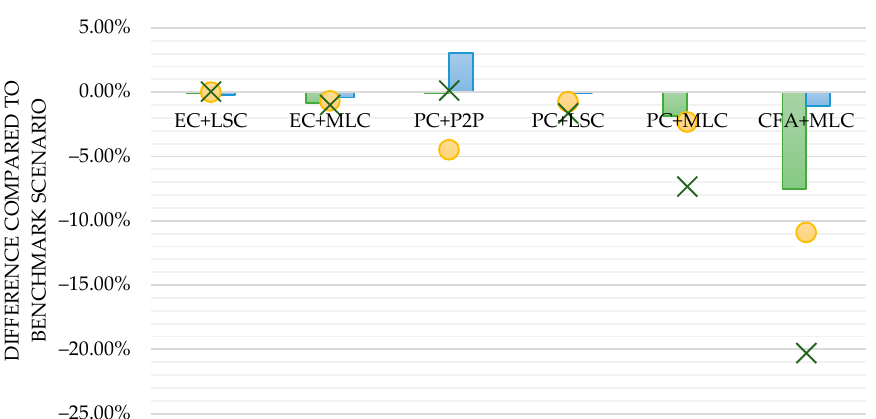
Figure 5. The relative difference in the performance of simulated scenarios compared to the bench- mark scenario; self-consumption, self-sufficiency: higher is better; LCOE, total operation cost: lower is better.